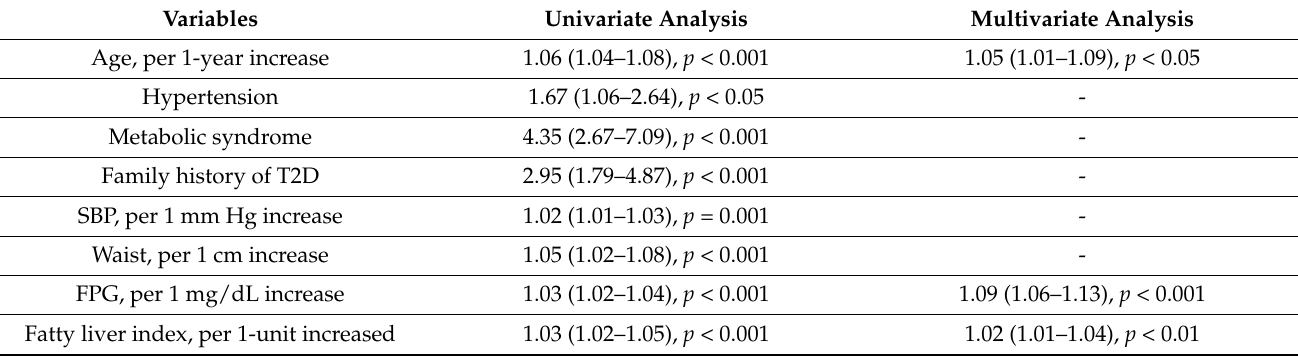
Table 2. Univariate and multivariate analyses of factors associated with incident type 2